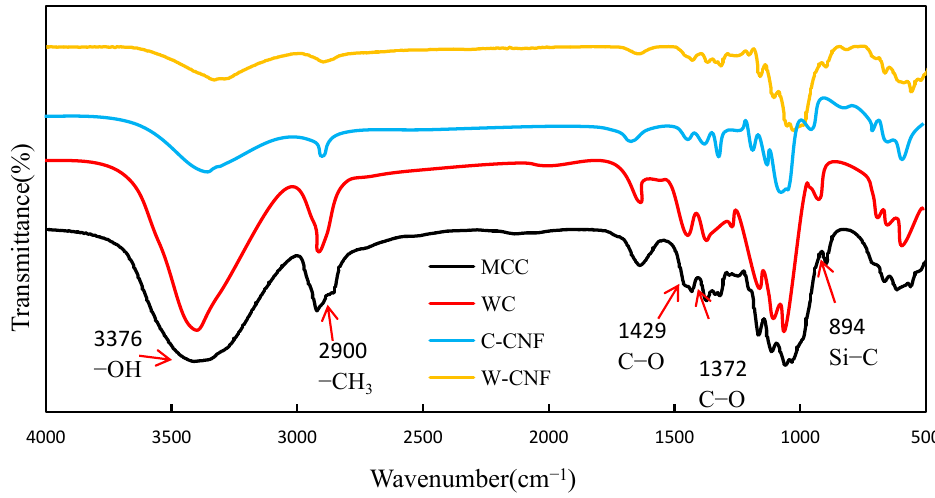
Figure 4. FT-IR of different cellulose samples.